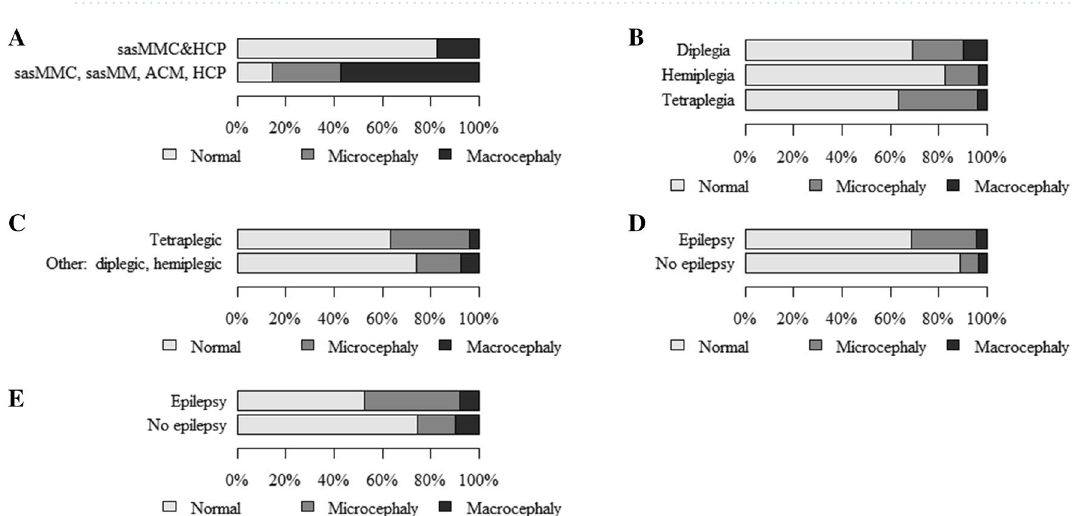
Figure 2. The size of the head: ( A )—traditional classification and encephalopathy in neural tube defects; ( B )— traditional classification and type of spasticity (Diplegia, Hemiplegia, Tetraplegia); ( C )—traditional classification and type of spasticity (Tetraplegic, Other: diplegic and hemiplegic together); ( D )—dysmorphology classification and epilepsy; ( E )—traditional classification and